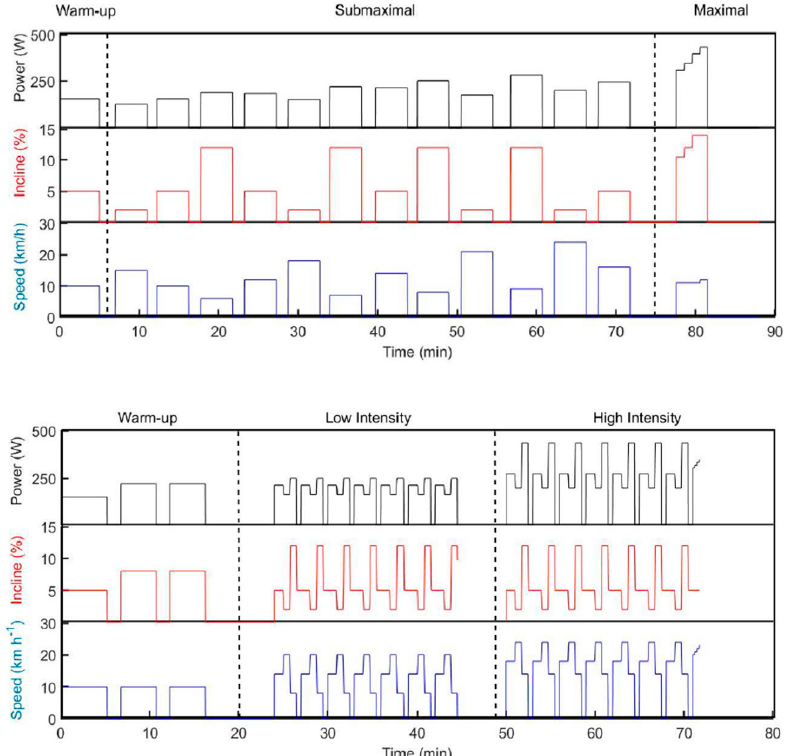
Figure 2. Top: Data from experiments at Day 1 showing submaximal bouts and a maximal incremental test. Bottom: Data from Day 2 showing 7 laps at low and high intensity.